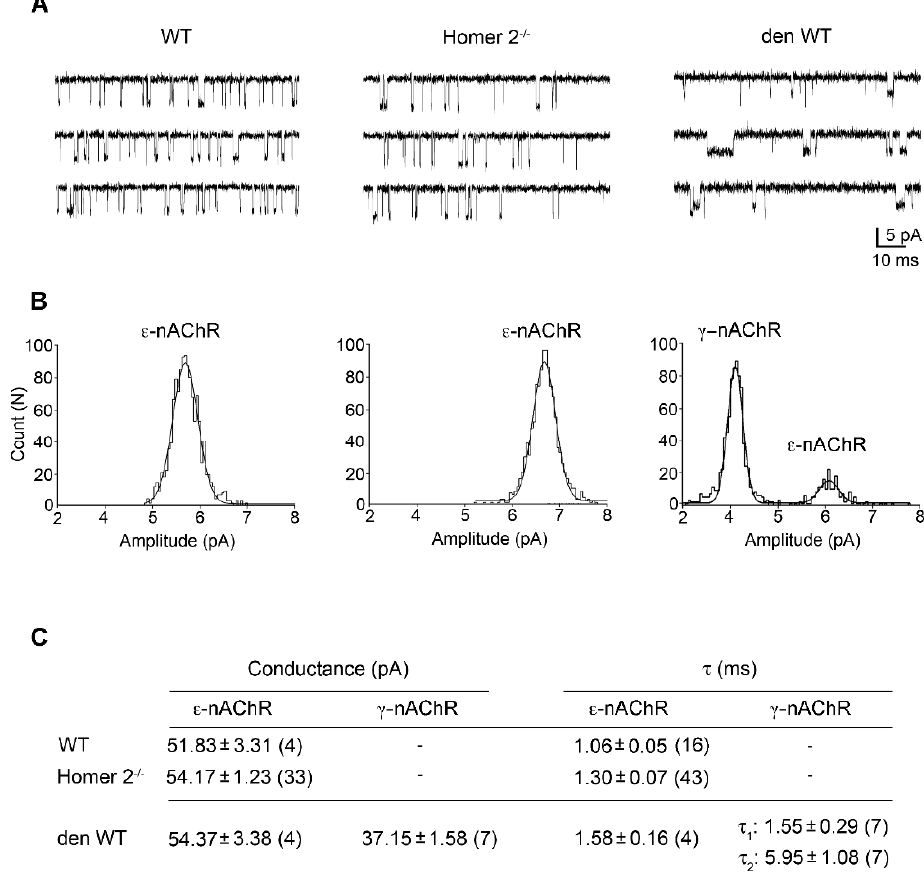
Figure 6. Single ‐ channel activity of nAChRs recorded from FDB endplates. ( A ) Representative single nAChR channel activity evoked by 200 nM ACh at the endplate regions of WT, Homer 2 ‐ / ‐ , and in vitro denervated WT FDB muscle fibres (i.e., 7 ‐ days cultured; den WT). At a pipette potential of +60 mV, channel openings appeared as downward deflections. ( B ) Corresponding unitary current amplitudes with the best fits superimposed. The analysis revealed the presence of the adult ε‐ nAChR openings alone in WT and Homer 2 ‐ / ‐ and the coexistence of adult ε‐ nAChR and foetal γ‐ nAChR openings in den FDB muscle fibres. ( C ) Mean values of conductance and time constants of the nAChR openings in WT, Homer 2 ‐ / ‐ , and den WT muscle fibres. Data are expressed as mean ± SEM. In parentheses, the number of the analysed recordings. Data were from 3 mice for WT, 15 mice from Homer 2 ‐ / ‐ , and 7 mice for den WT. The statistical analysis performed using one ‐ way ANOVA and Tukey’s post hoc test revealed no statistical differences among groups.